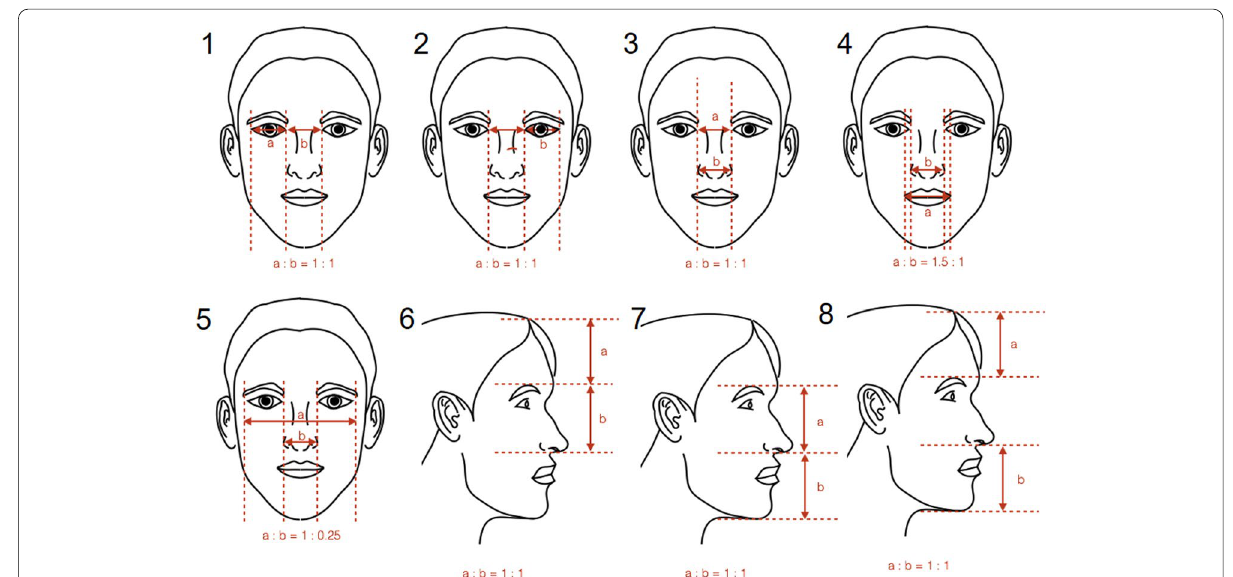
Fig. 4 Neoclassical canons measured in this